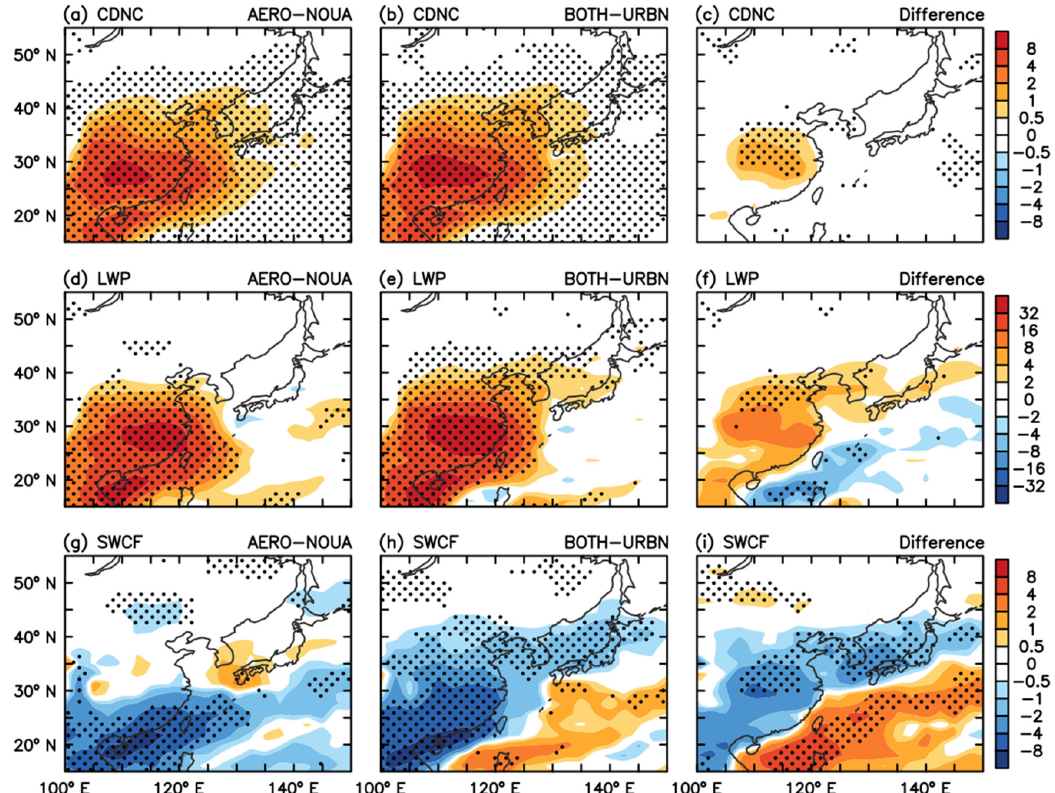
Figure 8. Same as Figure 5, but for ( a – c ) vertically integrated cloud droplet number concentration (CDNC; in 10 6 #/cm 2 ), ( d – f ) cloud liquid water path (LWP; in g/m 2 ), and ( g – i ) shortwave cloud forcing (SWCF; in W/m 2 ). A negative (positive) SWCF indicates that clouds reduce (enhance) the downward solar radiation at the surface, leading to a surface cooling (warming) effect.